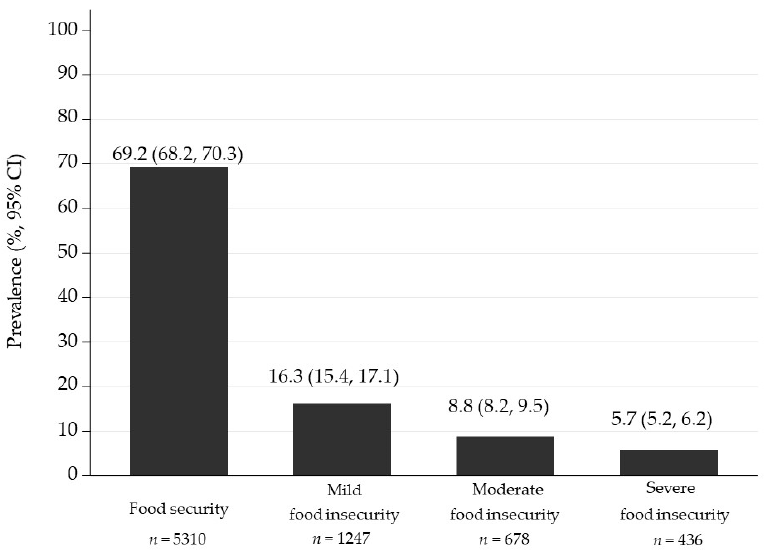
Figure 1. Prevalence of food security/insecurity in Mexican university students’ households, accord- ing to the Mexican Scale for Food Security ( EMSA, Spanish acronym ). As shown in Figure 2, FI prevalence of households in each state of Mexico ranged from 14.6% (95%CI: 10.0, 20.3), in Jalisco, to 59.5% (95%CI: 52.3, 66.4), in Tabasco. The higher prevalence of FI was found in the southern states of: Tabasco, Guerrero (56.6%; 95%CI: 48.1, 64.9), and Veracruz (50.5%; 95%CI: 43.3, 57.7). Supplementary Table S1 de- scribes the FI prevalence in each of Mexico’s states. Details on the total number of affirm- ative answers for each item on the EMSA are shown in Supplementary Table S2.